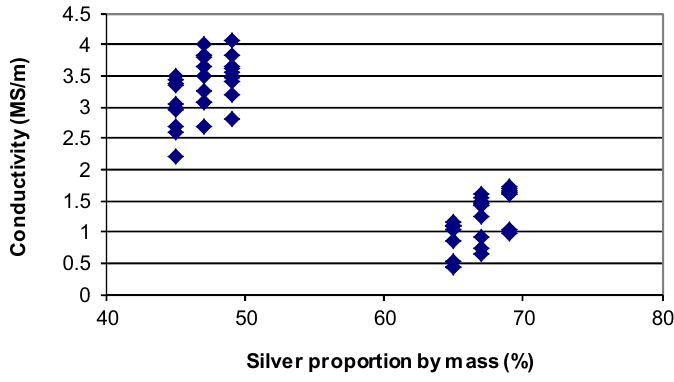
Figure 9 . Spread of printed material conductivities obtained with each material/film thickness combination.